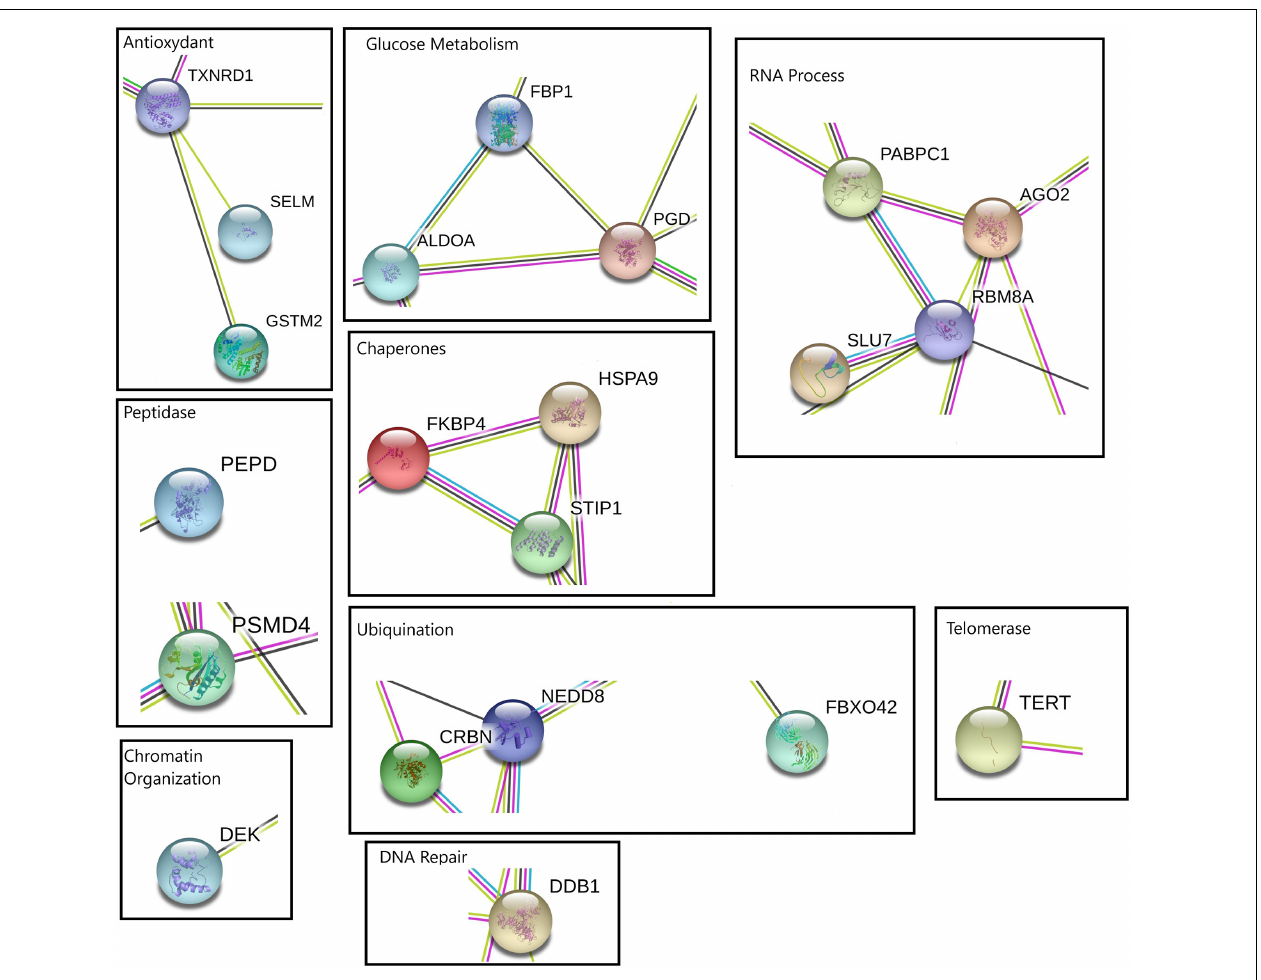
FIGURE 4 | Protein-protein interaction network performed with STRING online software using four kinetic points for up-regulated transcripts. The relevant molecular pathways were zoomed and placed in squares indicating cluster of transcript representations of each pathway. Please see Supplementary Material 3 and Supplementary Figure 6 for a complete view of protein-protein interaction